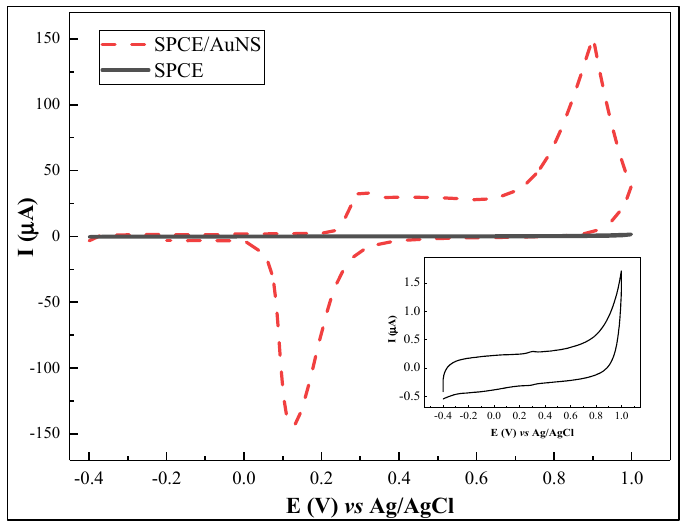
Figure 3. Cyclic voltammogram of SPCE/AuNS in 10 mM H 2 SO 4 . Inset: cyclic voltammogram of SPCE. Potential scan range was from − 0.4 to +1.0 V vs. Ag/AgCl, at a scan rate of 0.1 V/s.